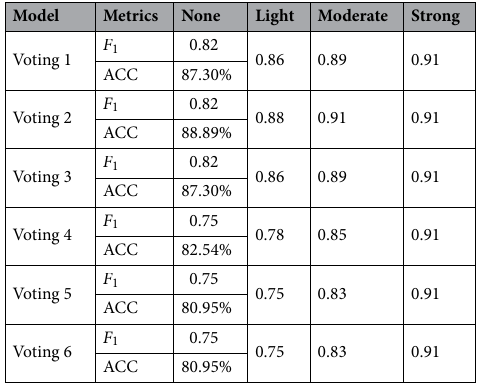
Table 11. The F 1 and accuracy in voting combination models.